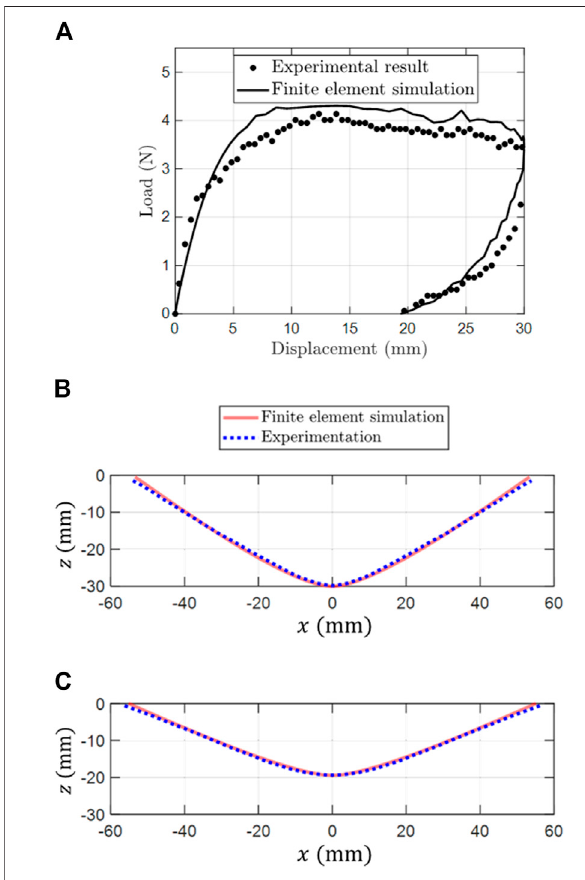
FIGURE 10 | Three-point bending test. (A) load/displacement curves at the point of load application. Numerical and experimental geometries of the deformed fabric: (B) at the end of the loading phase and (C) at the end of the unloading phase.